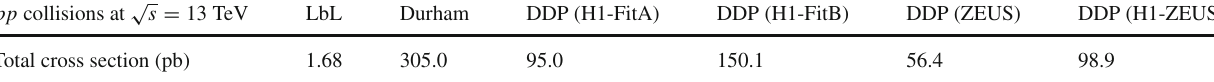
Table 1 Predictions for the diphoton production in double diffractive processes considering different modeling of the Pomeron structure. For comparison the predictions associated to the LbL scattering and exclusive (Durham) process are also presented. Results at the generation level √ pp collisions at s = 13 TeV LbL Total cross section (pb) Fig. 2 Predictions for the invariant mass m γγ , transverse momentum p T (γγ) and rapidity y γγ distributions of the diphoton system produced in pp collisions at the LHC. Results obtained at the generation level, without the inclusion of experimental